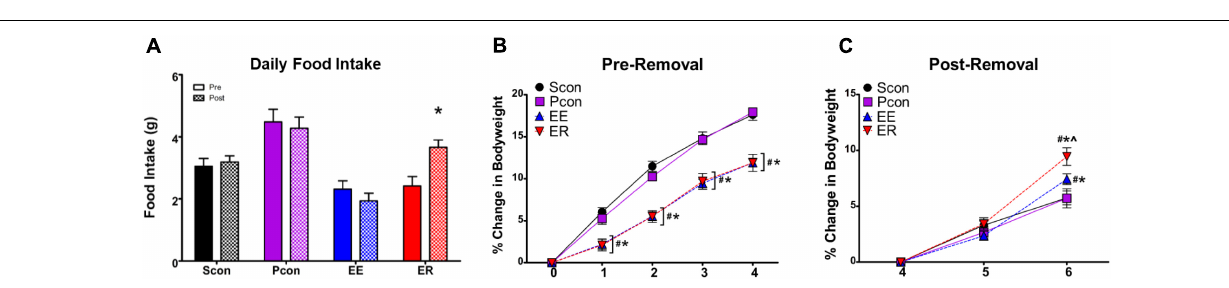
FIGURE 4 | Enrichment removal leads to hyperphagia and an increase in body weight gain. (A) Enrichment removal increases inactive cycle food intake ∗ p < 0.05 vs. pre for the ER group only. (B) Enrichment leads to an attenuation of body weight gain for both EE and ER groups relative to pair housed controls (Pcon) and single housed animals (Scon) for the first 4 weeks of enrichment # p < 0.05 vs. Scon, ∗ p < 0.05 vs. Pcon. (C) Rate of change in body weight is increased in the EE group and exaggerated in the ER group at 2 weeks post removal # p < 0.05 vs. Scon, ∗ p < 0.05 vs. Pcon, ∧ p < 0.05 vs.